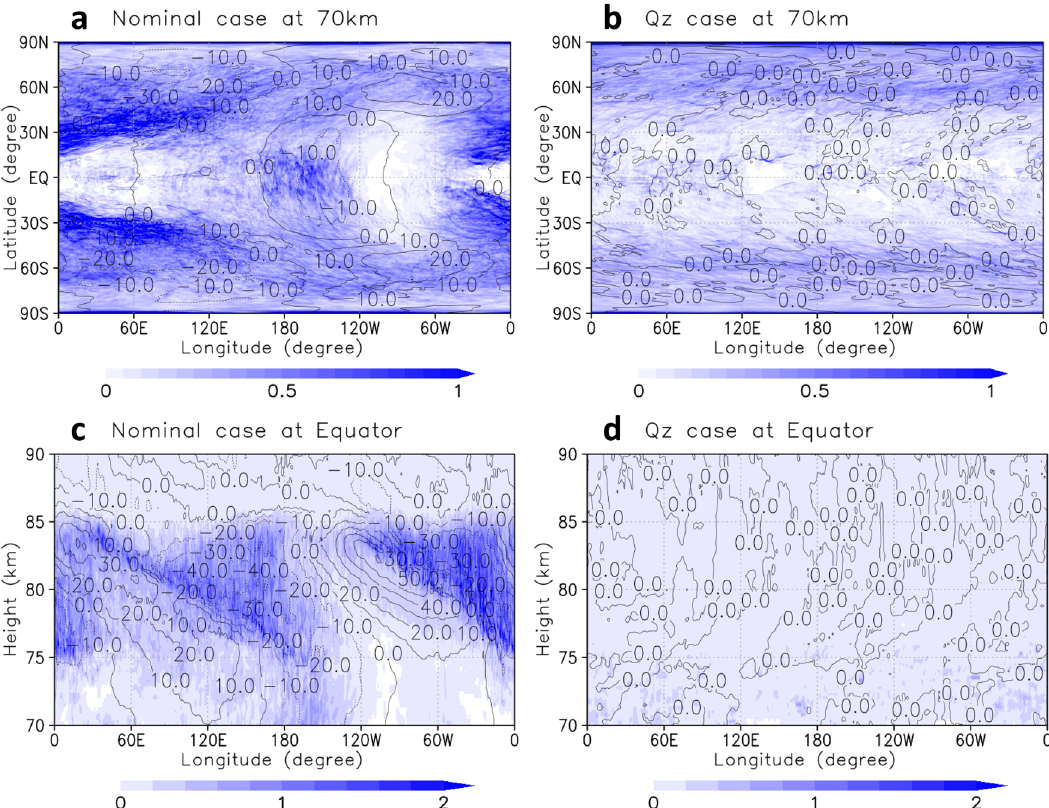
Fig. 3 Lagrangian Rossby Number (Ro (L) ; colour shade). a , b Longitude – latitude cross-sections of Ro ð L Þ at the cloud-top (~70 km) level for the nominal and Qz cases, respe c tively. c , d Longitude – height cross-sections of Ro ð L Þ at the equator for the nominal and Qz cases, respectively. The values are calculated using the advected tendency term in Eq. (2) with effective Coriolis parameters by Eq. (3) and have been averaged over 30 Earth days in a solar- fi xed reference frame (i.e., composite-mean). Atmospheric density normalisation ρ = ρ z ¼ is multiplied in c and d . Deviations of zonal fl ow from its zonal 70km average (black contours; intervals are 10 m s − 1 ) are also shown. The subsolar point is located at the centre of panels, (180°E, 0°N), for a and c